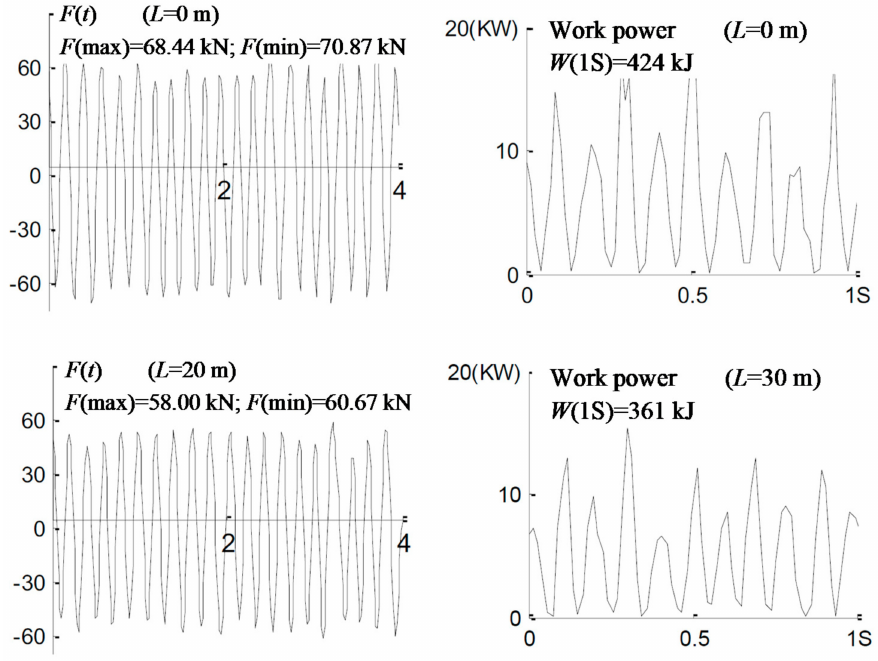
Figure 23. The time − domain diagrams of equivalent excitation force and its work power to the spring component under different spring